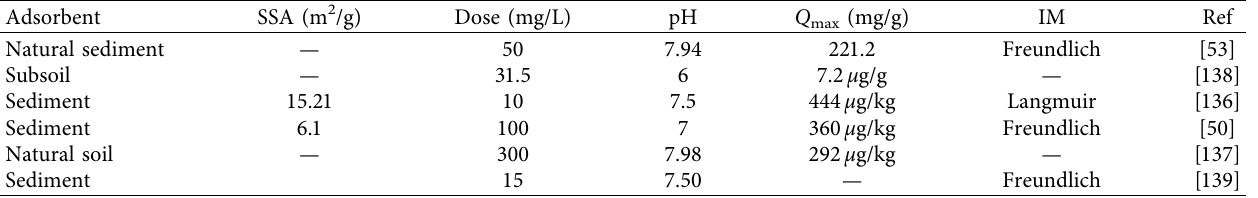
Table 10: Summary of characteristics of soil and sediment adsorbents and conditions of the adsorption process. Adsorbent